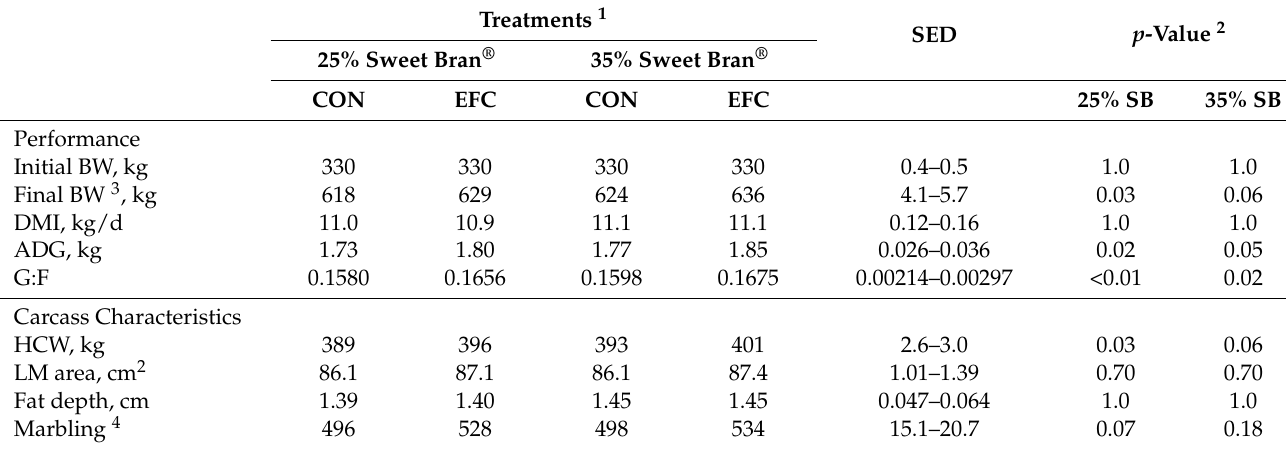
Table 3. Effect of the corn hybrids (EFC and CON) fed as dry-rolled corn in diets with Sweet Bran ® on predicted least-square means when finishing cattle performance and carcass characteristics are modeled.